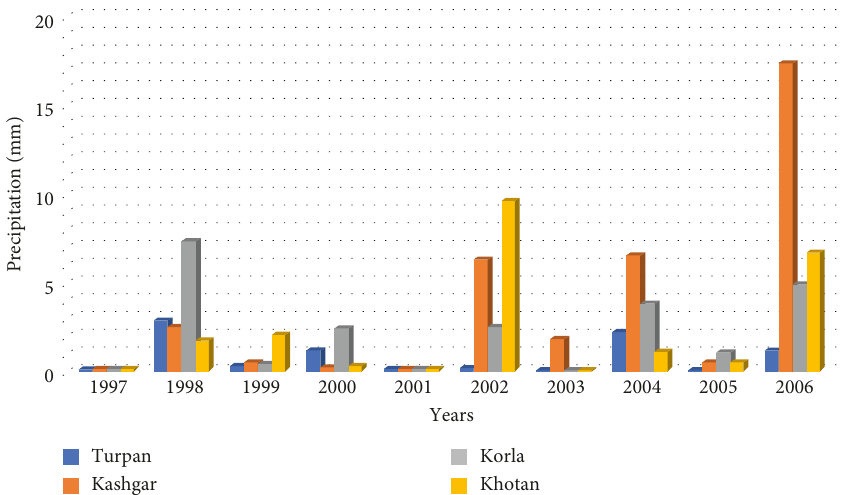
Figure 4: The precipitation in southern Xinjiang in January from 1997 to 2006.